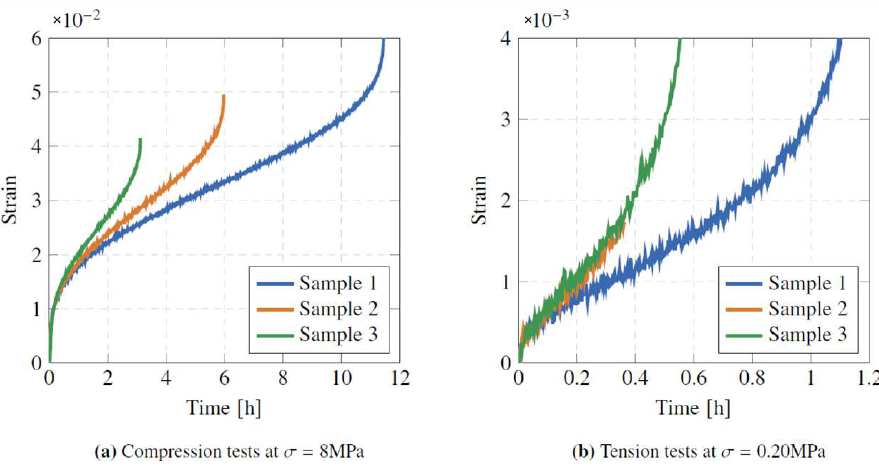
Figure 4. Three stages of creep at T = 1300 ◦ C under tensile and compressive loads.